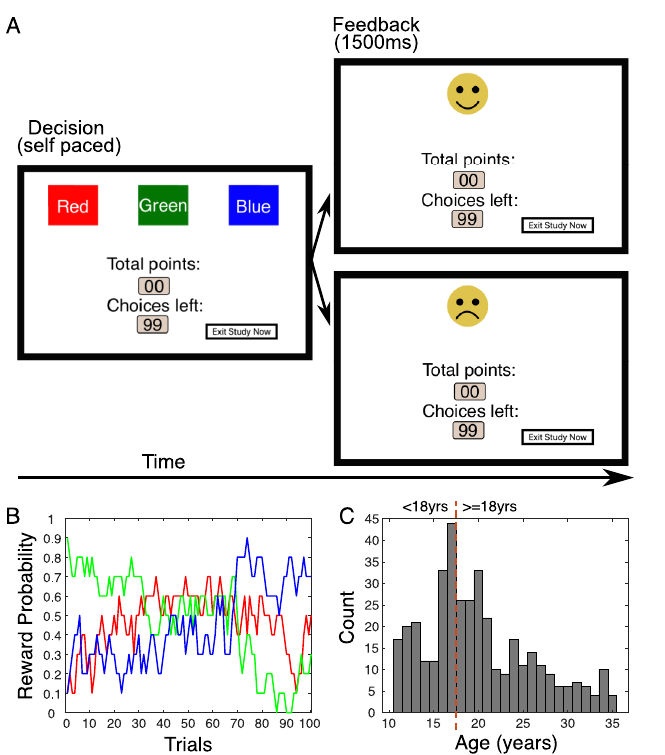
Fig 1. Task design, reward schedule, and sample. (A) Trial timeline: Participants decided between three choice options (red, green, blue squares; left-hand side) before receiving feedback for 1,500 ms (right-hand side) indicating whether their choice yielded a reward (10 points and smiley face) or no reward (no points and sad face). Both possible outcomes are displayed in this example. (B) Reward probabilities ranged between 0 and .9 and drifted throughout the session with each option being competitive at some time during the session. (C) Age distribution of the final sample with dashed line indexing the age groupings cutoff at 18 years. Participants younger than 18 are referred to as adolescents; participants 18 years and older are referred to as young adults . Data for B and C are available in S1 Data (Figure1 tab).